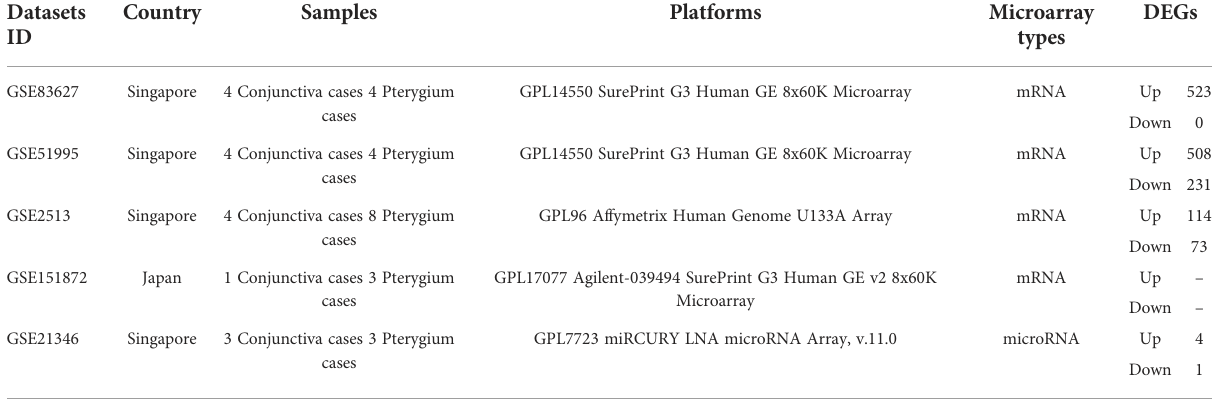
TABLE 2 The descriptions of GEO datasets used to perform subsequent analyses.